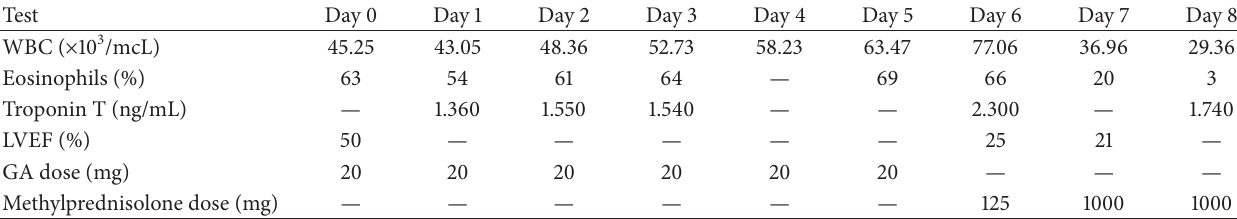
Table 1: Time course of medication administration and laboratory data.